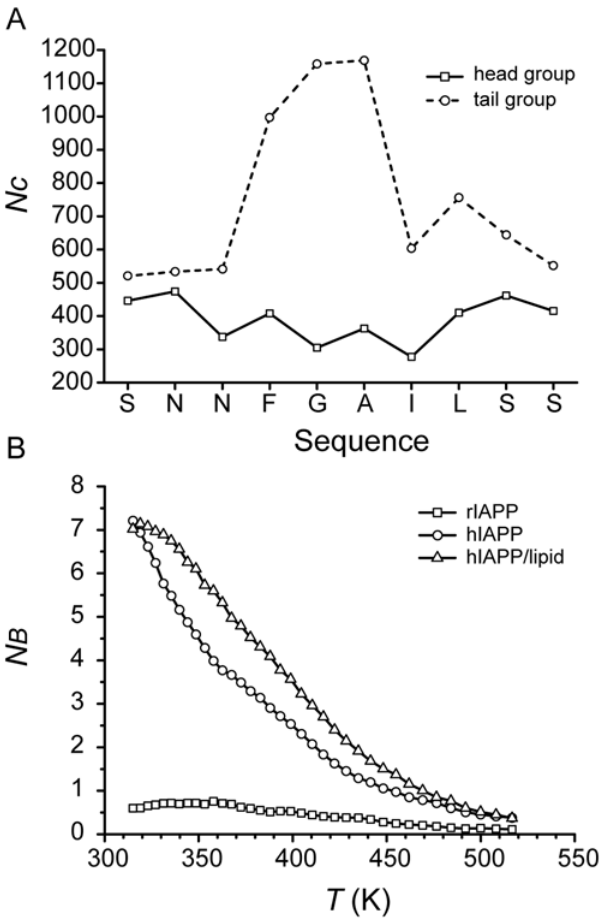
Figure 9. The influence of lipid on peptide aggregation. (A). Occurrences of atomic contacts (N C ) between heavy atoms on lipid head (square symbol, sold line) or tail (circle symbol, dashed line) groups and C a atoms on hIAPP fragment. Distance cutoff is 0.6 nm. The counts are scaled by the total atom number of head or tail group in order to prevent the bias favored by large atom number of tail group. (B). Temperature dependence of number of b -bridges N B averaged over the ensemble trajectories at the same temperature.